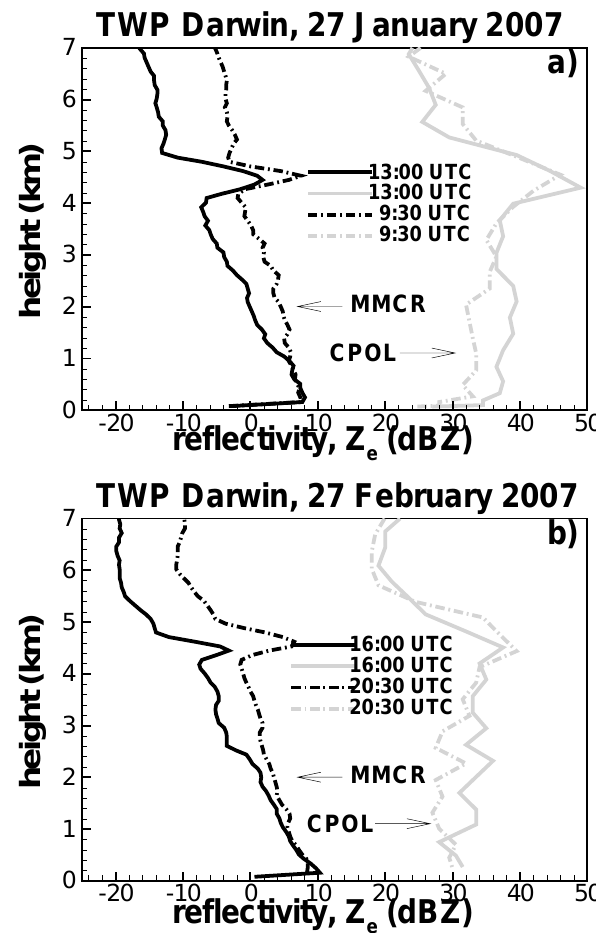
Fig. 2. Vertical profiles of MMCR and C-POL reflectivity observed at two different times during the stratiform precipitating events of 27 January 2007 (a) and 27 February 2007 (b) .